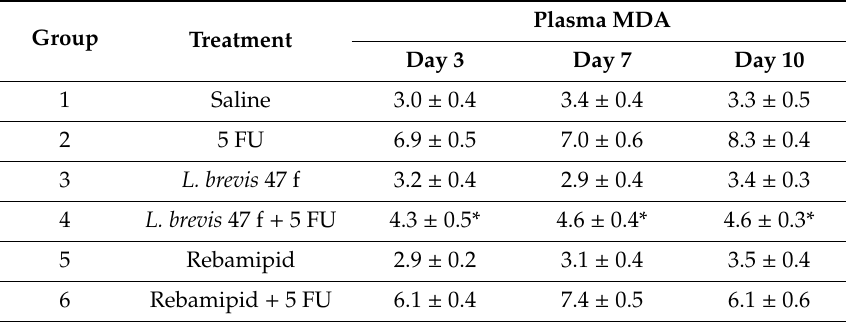
Table 6. Time course of MDA levels in the female plasma.